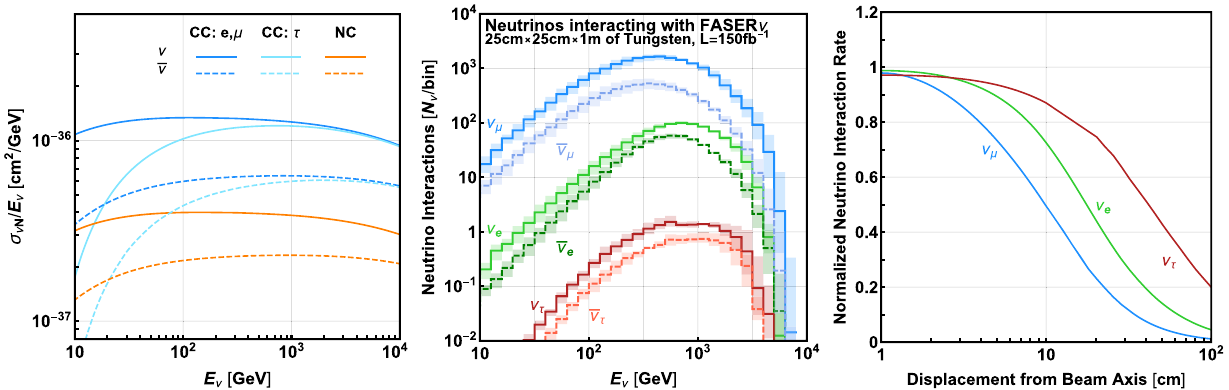
Fig. 5 Left :The ν N (solid)and ¯ ν N (dashed)DIScrosssections,where N is a tungsten nucleus, calculated with the NNPDF3.1 PDF [80]. Cen- ter : The energy spectrum of neutrinos with CC interactions in a 1-t tungsten detector with dimensions 25cm × 25cm × 1m centered on